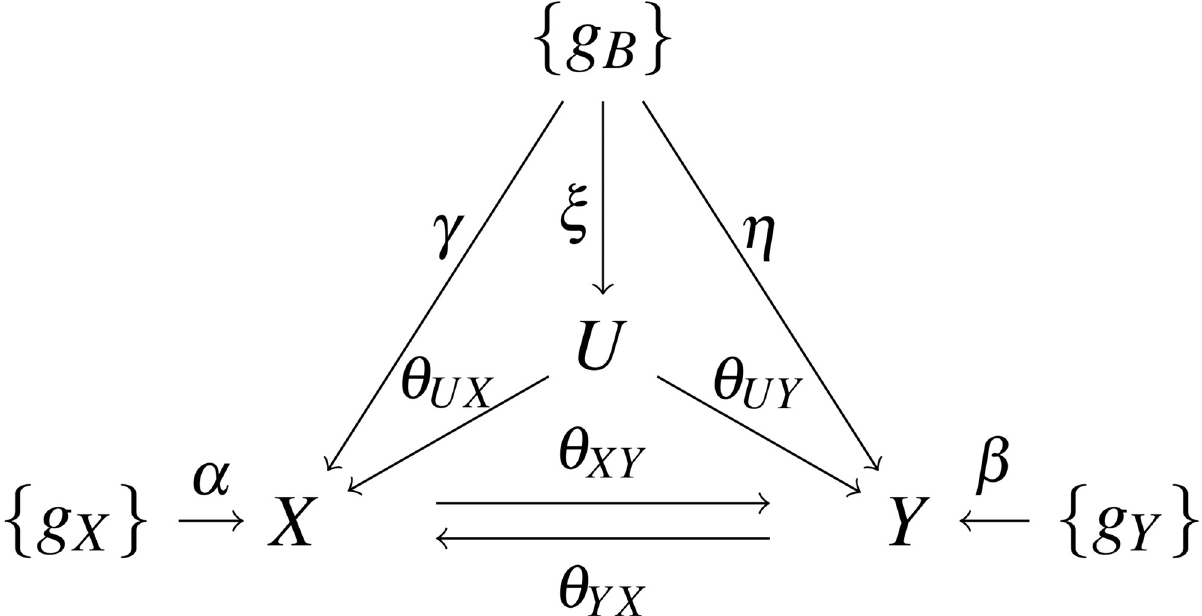
Fig 1. The true causal model with two traits X and Y of interest. U is a hidden confounder (or an aggregate of hidden confounders). The IVs in { g and { g } are valid for X and Y respectively, and the IVs in { g Y estimated. The arrows give the directions of the direct causal effects (with the effect sizes shown). In particular, θ XY and θ YX are the causal effects from X to Y and from Y to X respectively, and are parameters of